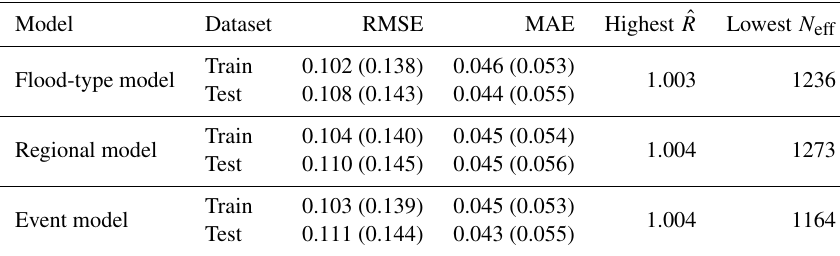
Table 6. Performance indicators over mean values of the posterior predictive distribution (median of performance indicators over the full posterior predictive distribution) and convergence indicators of the three model variants. RMSE: root mean square error; MAE: median